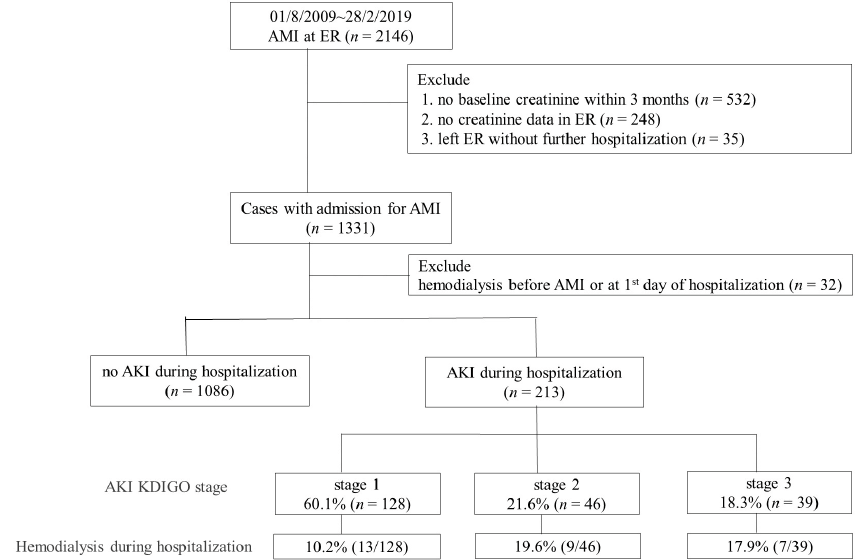
Figure 1. Algorithm and summarized results of the study. AMI: acute myocardial infarction; AKI: acute